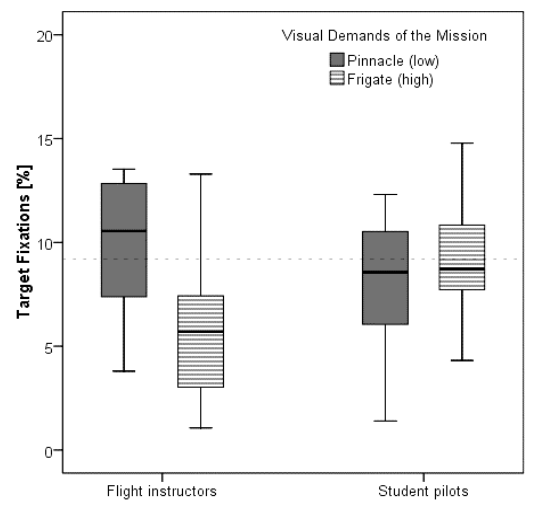
Figure 6. Boxplot for TF (M for total sample dashed). Figure 7. Boxplot for Performance (M for total sample